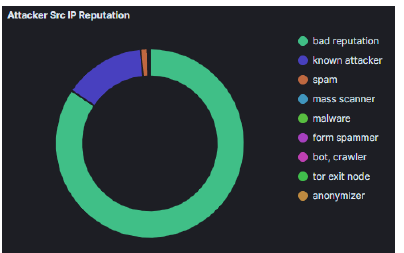
Figure 12. Microsoft Azure Attacker Src IP